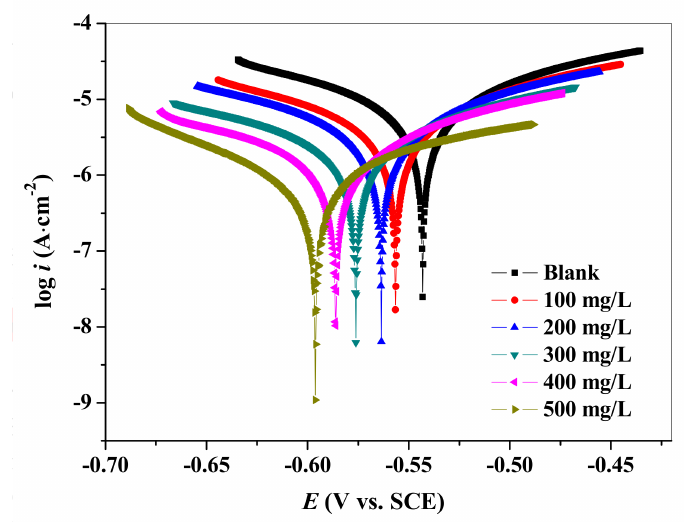
Figure 5. Polarization curves for carbon steel in the absence and presence of di ff erent concentrations of TPP at 25 ◦